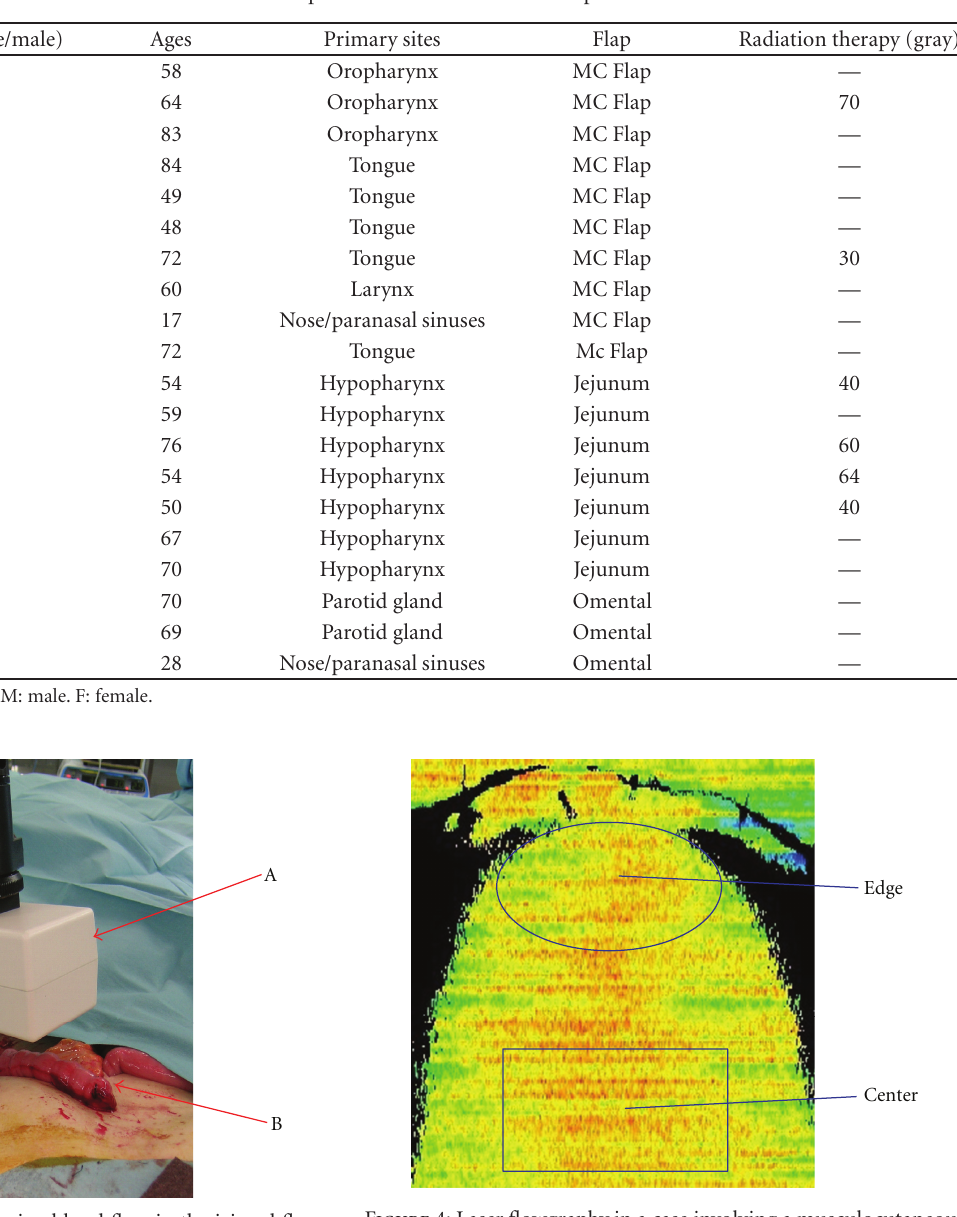
Table 1: The number of parts of cancer and kinds of flap.